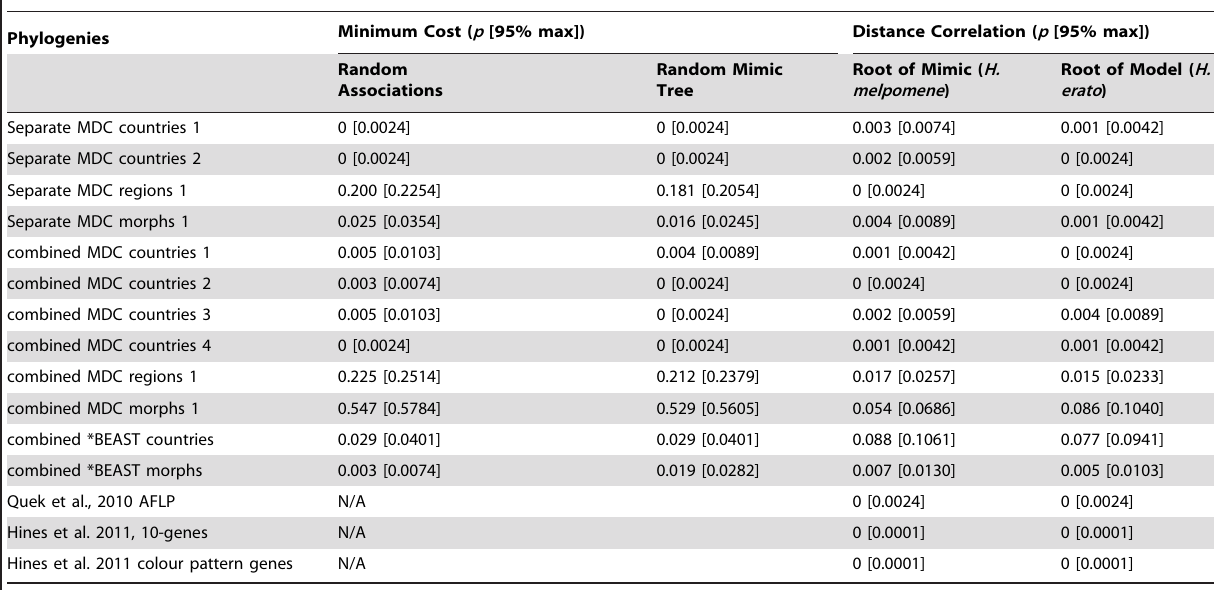
Table 1. Significance of topological congruence between H. erato and H. melpomene